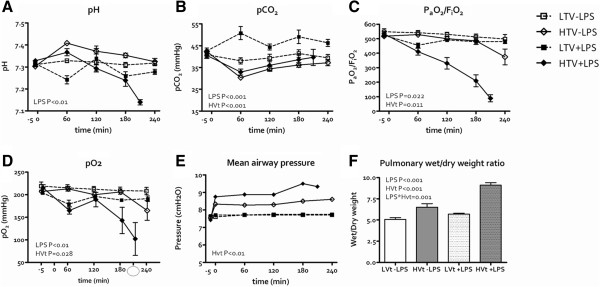
Ventilator-induced lung injury induction in the course of time (LPS=lipopolysaccharide; LVt=low tidal volume (Vt) ventilation, HVt=high Vt ventilation). A. pH. B. PCO2. C. PaO2/FiO2. D. PO2. E. Mean airway pressure. F Pulmonary wet/dry ratio increased by LPS and HVt ventilation interaction.